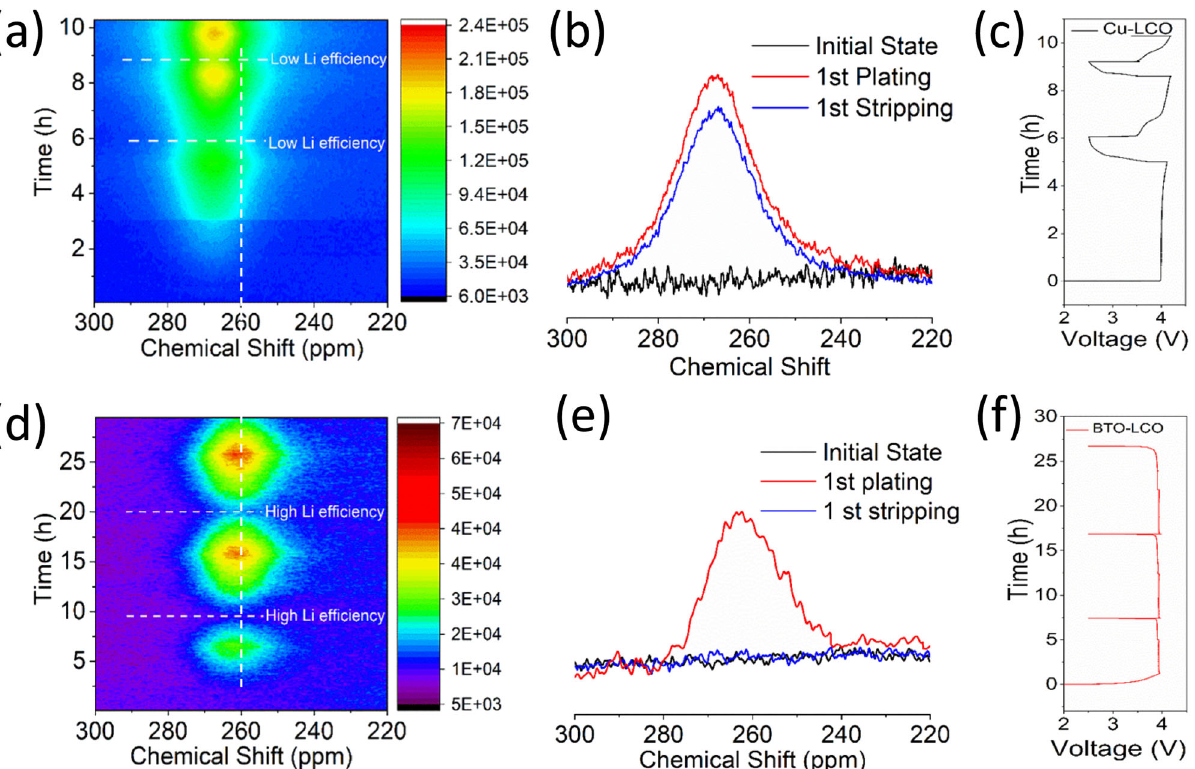
Fig. 2 Operando 7 Li solid-state NMR of Li metal plating/stripping on bare Cu and the BTO-coated Cu substrates in full cell con fi guration. a – c Bare Cu versus a LiCoO 2 positive electrode with a 1 M LiPF 6 EC/DMC electrolyte cycled at 0.2 mA cm − 2 to 1 mA h cm − 2 charge capacity and discharged to 2.5 V cut-off. a 2D 7 Li operando NMR spectra as a function of cycling, b 1D 7 Li solid-state NMR spectra at selected conditions, c voltage pro fi le. d – f Anode-free BTO scaffold on Cu versus a LiCoO 2 positive electrode with a 1 M LiPF 6 EC/DMC electrolyte cycled at 0.2 mA cm − 2 to 1 mA h cm − 2 charge capacity and discharge to 2.5 V cut-off. d 2D 7 Li operando NMR spectra as a function of cycling, e 1D 7 Li solid-state NMR spectra at selected conditions, f voltage pro fi